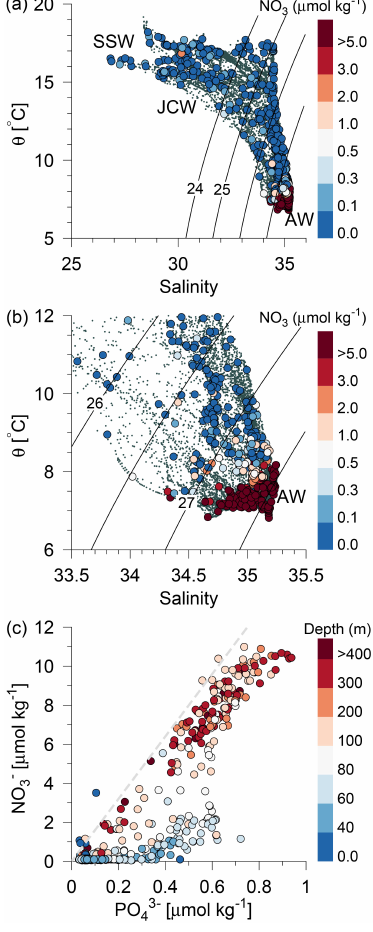
Figure 4. (a) Potential temperature–salinity diagram of all CTD measurements and (b) a high-saline subset of the measurements (small grey bullets). Water sample concentrations of nitrate are shown by large bullets in (a, b) (µmolkg − 1 , colour bar). Contour lines show isopycnals of potential density anomalies, and selected water masses are indicated. (c) Nitrate vs. phosphate for all water samples. The total water depth is shown with colours (m) and the re- lationship [NO − ] = η N : P [PO − ], η N : P = 16 : 1, is shown by a grey 3 4 dashed